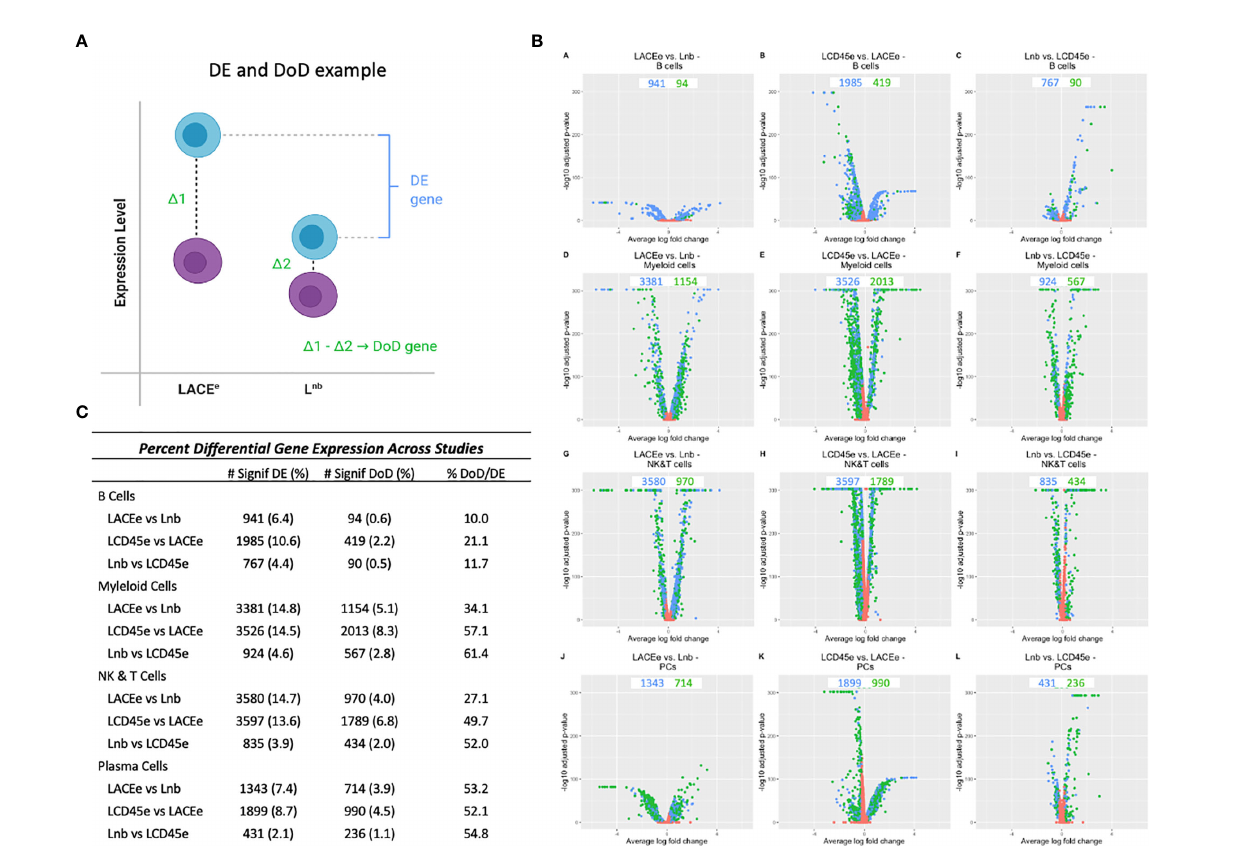
FIGURE 3 | Differential gene expression analysis between datasets. (A) Schematic diagram for identi fi cation of a differentially expressed (DE) gene. The blue cells represent different expression levels for a gene in each leukocyte subpopulation (e.g., expression in B cells) and the purple cells represent the expression levels of that same gene, but in all other cell subpopulations. Differential expression only takes levels from the B cell into account. We also examine the Difference of Differences (DoD) which takes the difference in expression between B cells and all other cell types for dataset #1 and subtracts it from the differences in expressed between B cells and all other cell types for dataset #2 which may help categorize the differential expression that is accounted for by technical differences between studies (such as sequencing depth) rather than biologically relevant changes. (B) Volcano plots showing the number of DE genes (blue dots) and DoD genes (green dots) for each dataset condition as pairwise comparisons between studies and strati fi ed by cell type. (C) Lists of differential gene expression numbers, DoD genes and then the percent of DoD genes out of the number of DE